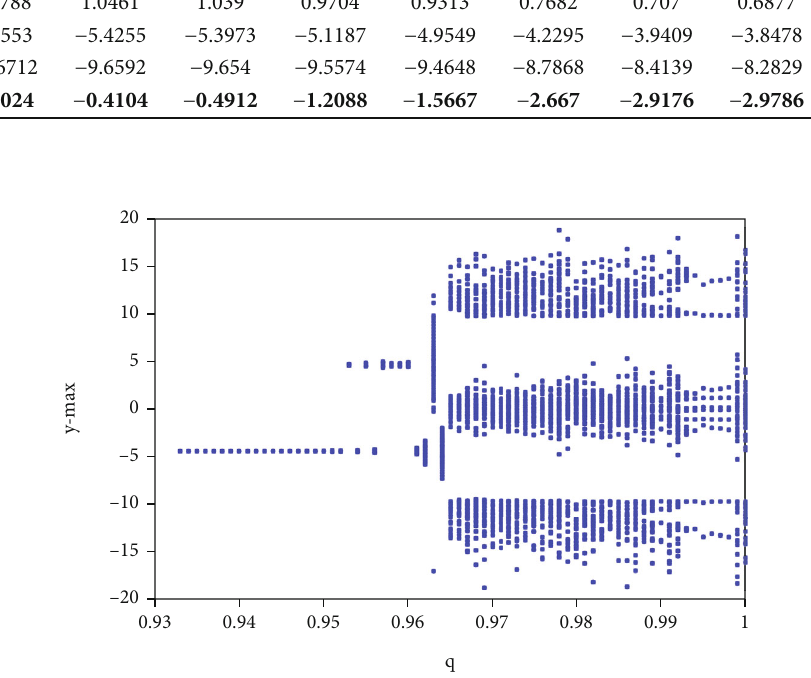
Figure 1: Bifurcation diagram of (5) due to orders from 0.93 to